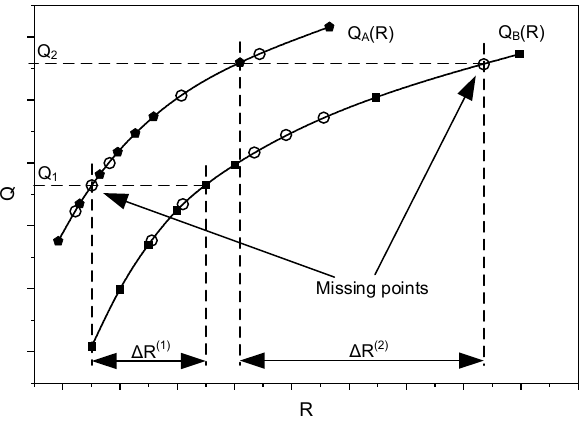
Figure 3. Calculation (issue) of the delta rate based on the real video samples.